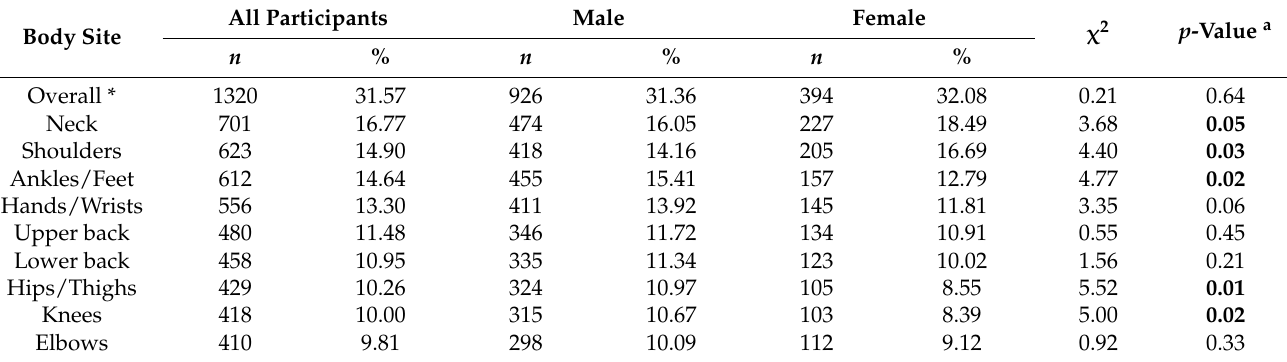
Table 2. Prevalence of WMSDs among furniture manufacturing workers, classified by body regions and gender.